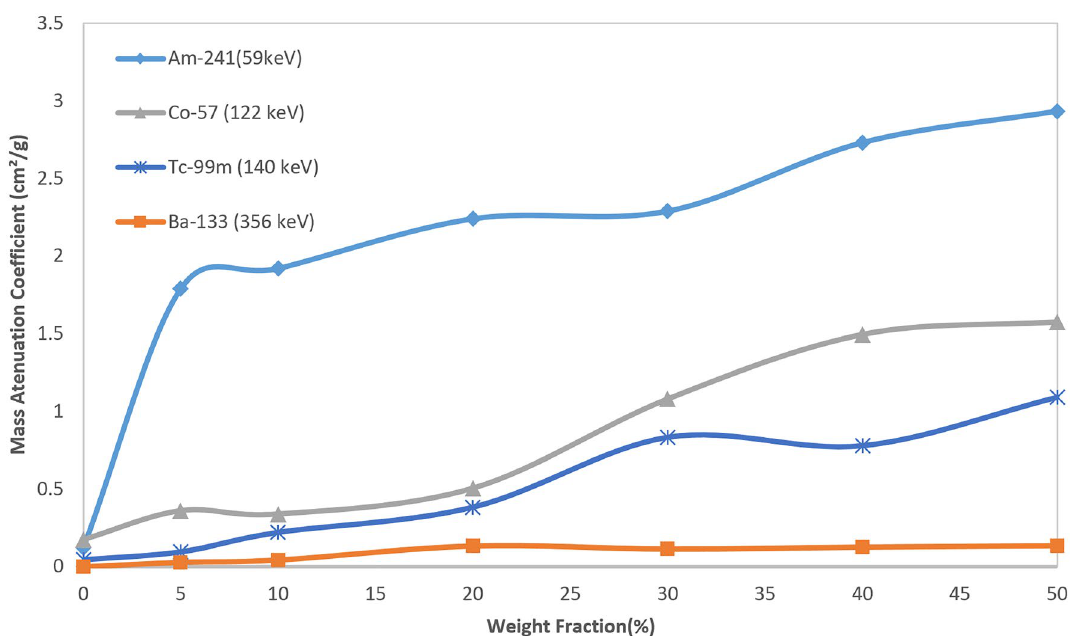
Figure 8. Mass attenuation coefficient result of different specimens for four gamma